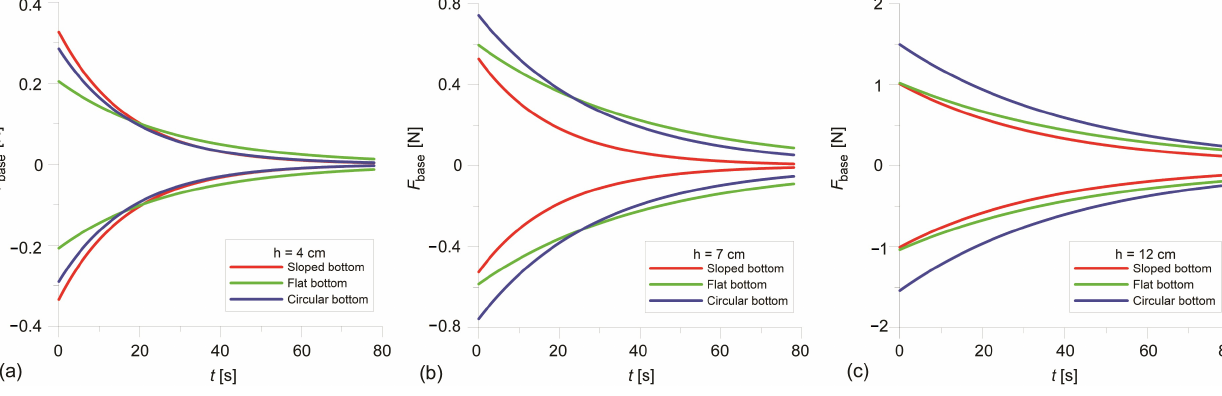
Figure 9. Comparison of exponential decay functions between the different bottom shapes for water depth of h = 4 cm ( a ), h = 7 cm ( b ) and h = 12 cm ( c